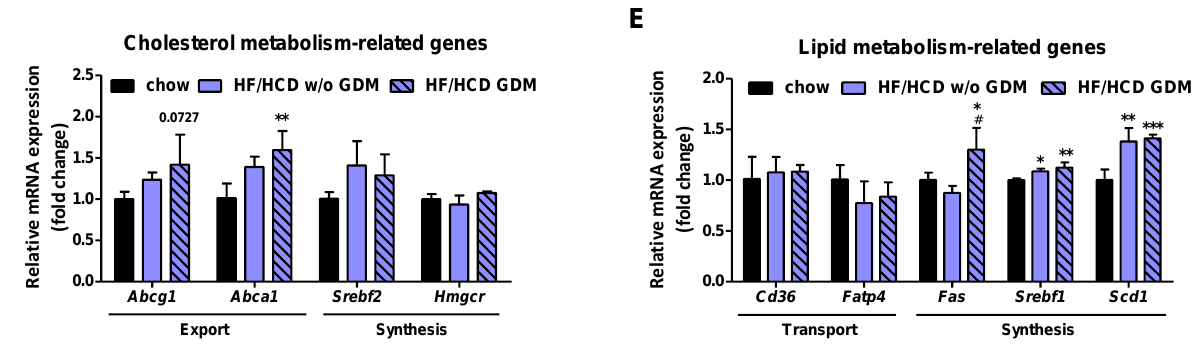
Figure 3. Increased placental cholesterol export in GDM. ( A ) Neutral CE hydrolase activity and ( B ) acid TG hydrolase activity in placentae of chow, HF/HCD w/o GDM, and HF/HCD GDM dams ( n = 4–5). Gene expression levels of ( C ) lysosomal, ( D ) cholesterol export- and synthesis-related genes, and ( E ) lipid-metabolism-related genes in placentae of these mice ( n = 4). Data represent mean + SD and were analyzed with 1-way ANOVA followed by Bonferroni post hoc test. * p < 0.05, ** p ≤ 0.01, *** p ≤ 0.001, indicating the comparison to the chow condition and # p < 0.05 the comparison between HF/HCD w/o GDM and HF/HCD GDM. 2.4. Fetal Hepatic Lipid Accumulation after Maternal HF/HCD Feeding and GDM Development To study the consequences of maternal HF/HCD feeding and the consequent development of GDM on the unborn mouse, we determined hepatic and plasma lipid levels as well as hepatic lipid metabolism-related gene expression in fetuses at GD 19. Although brain weight was higher in HF/HCD-fed and GDM mice (Figure 4A), liver weight remained unaltered (Figure 4B), resulting in a slightly elevated brain-to-liver ratio (a measure to identify intrauterine growth restriction [30]) in offspring from HF/HCD-fed but not GDM mice (Figure 4C). Offspring of GDM dams showed elevated circulating TG but unchanged CE (Figure 4D) and non-esterified FA (NEFA) levels in fetal plasma (Figure S4A). Accumulation of TG and CE was more pronounced in fetal livers of HF/HCD and GDM dams (Figure 4E) than in their respective placentae (Figure 2B). In addition, only fetuses of GDM mothers showed increased mRNA expression of hepatic de novo lipogenesis and cholesterol synthesis genes (Figures 4F and S4B), most likely due to increased fetal plasma glucose concentrations (Figure 4G). These results suggest that increased fetal hepatic lipid concentrations are not only a consequence of increased lipid synthesis as also seen in HF/HCD fed dams without GDM. Moreover, increased liver lipid accumulation might contribute to fetal overgrowth upon maternal HF/HCD feeding with and without GDM.